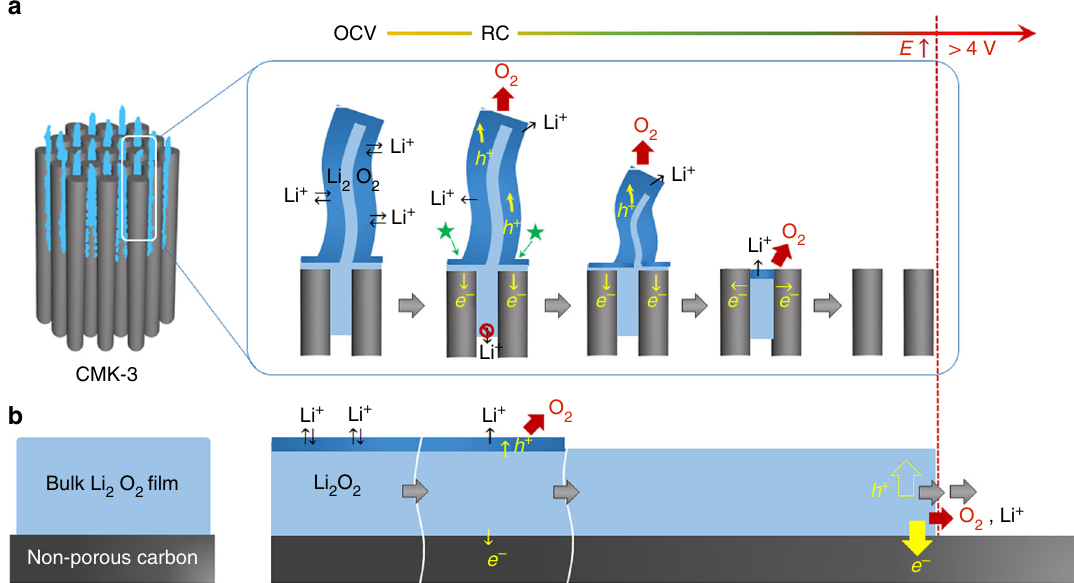
Fig. 7 Schematic illustration for decomposition processes. a 1-D nanostructured and b bulk Li 2 O 2 fi lm. The dark blue region that is distinguished from inside of Li 2 O 2 with the light blue color indicates activated Li 2 O 2 surface where free access of Li + is allowed. The star mark denotes highly conductive sites where Li 2 O 2 , electrode, and electrolyte solution closely contact. Once RC commences, facile Li + dissolution and charge transport takes place along the activated Li 2 O 2 surface, which results in O 2 evolution and decomposition of Li 2 O 2 at low potential. The charge carrier hole in Li 2 O 2 and electron are denoted as h + and e – , respectively. Since Li + dissolution of Li 2 O 2 enclosed within the mesoporous channel would violate charge balance rule, this part of Li 2 O 2 decomposes later. The bulk Li 2 O 2 fi lm decomposes sluggishly due to the limited surface area of Li 2 O 2